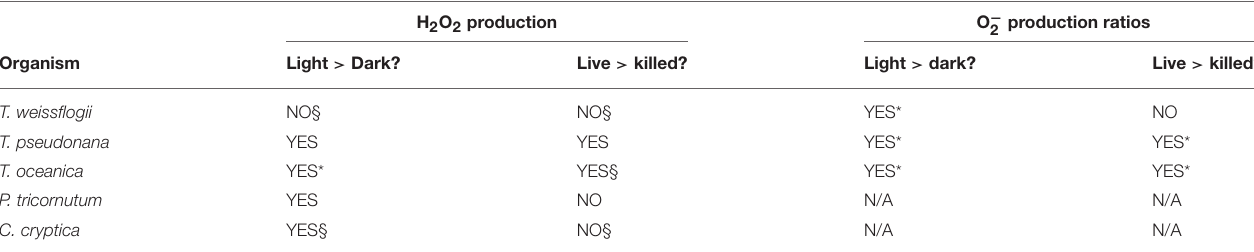
TABLE 2 | Summary of light vs. dark and live vs. killed comparison for H 2 O 2 and O − 2 production rates.